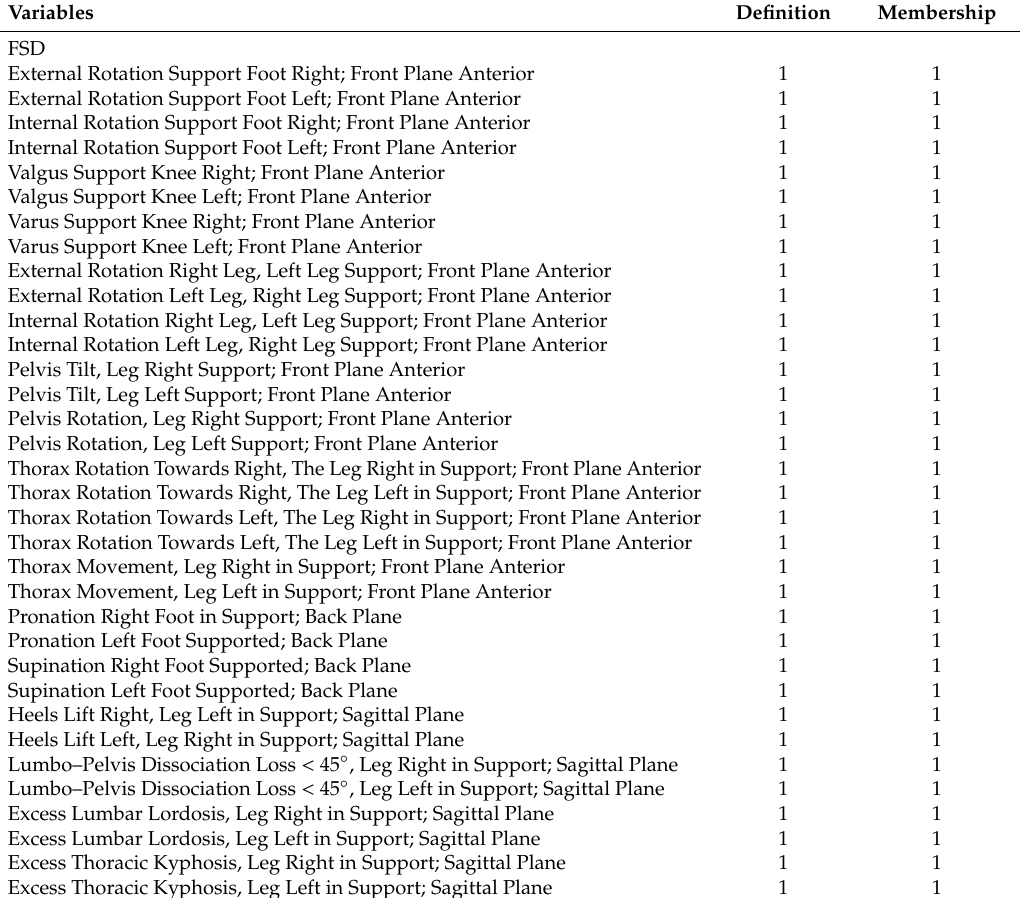
Table 5. Assessment of Aiken V by ten experts of the proposed variables for